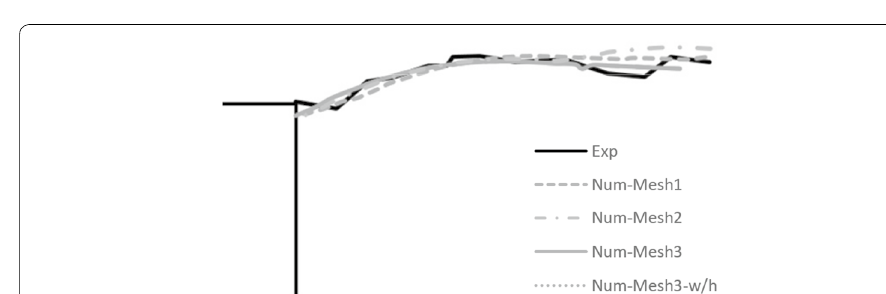
Fig. 14 Comparison of numerical and experimentally observed crack pattern